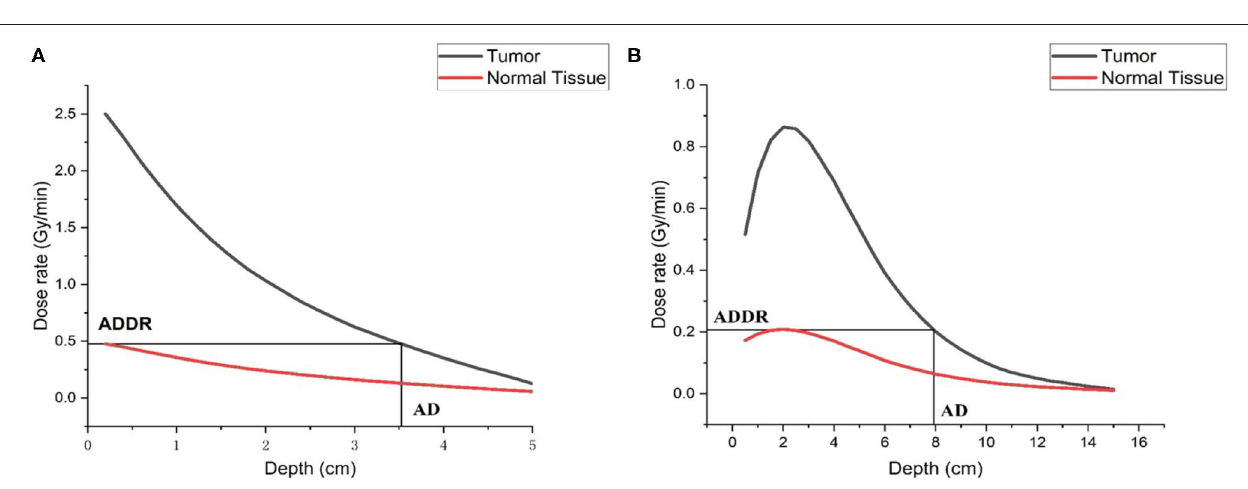
Frontiers in Public Health |